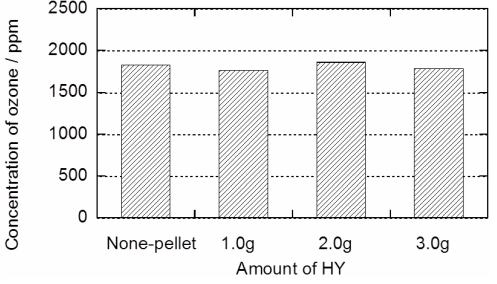
Figure 5. Concentration of ozone in the downstream reactor with amount of